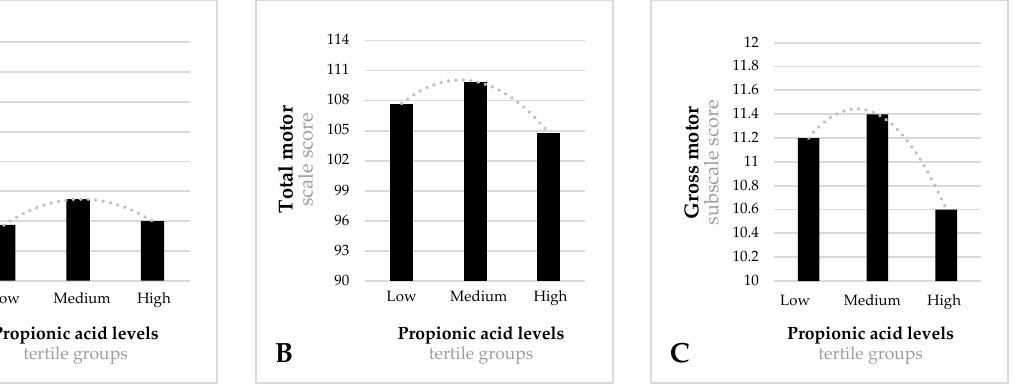
infant’s sex, breastfeeding at 40 days postpartum, and bonding difficulties.